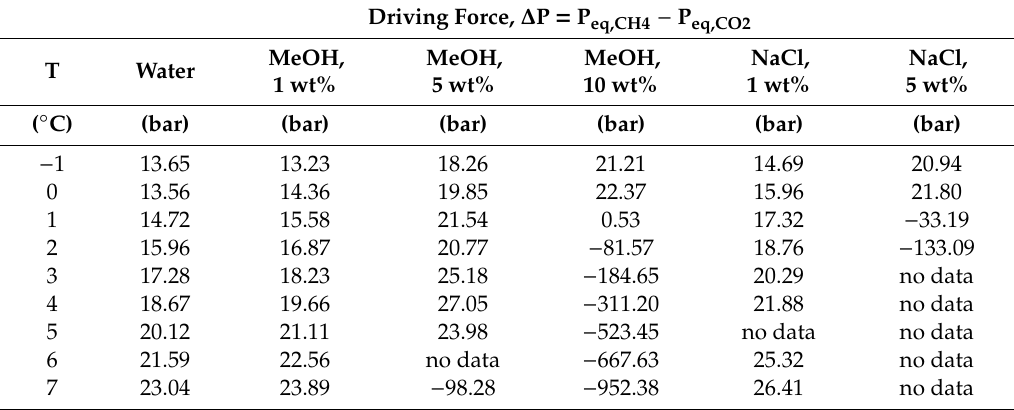
Table 2. Change in driving force (P eq,CH4 − P eq,CO2 ) at di ff erent temperatures in the presence of di ff erent concentrations of methanol and NaCl. Values were calculated using CSMGem software.